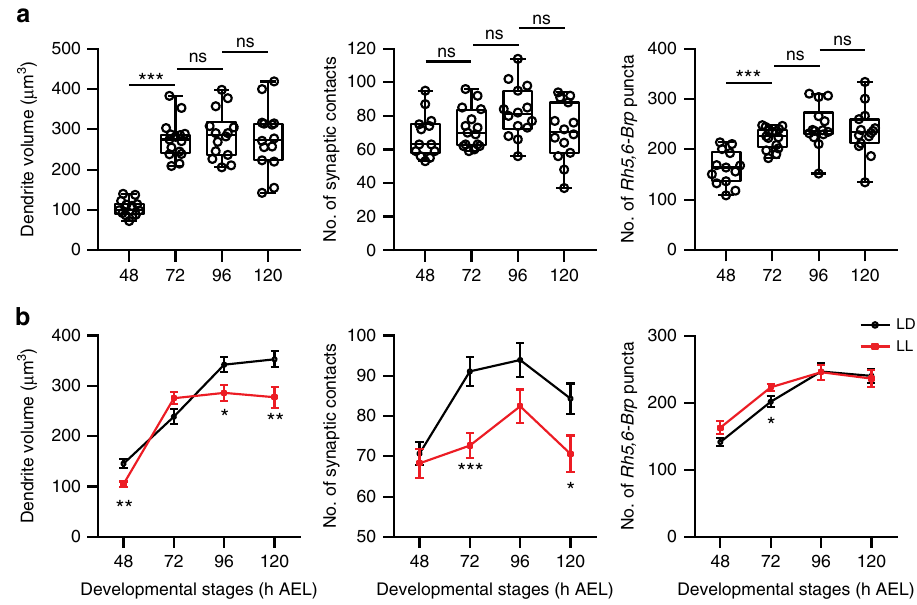
Fig. 5 Experience-dependent modi fi cations of dendrite growth and synaptogenesis in LNvs. a LL conditions alter the temporal pro fi le of dendrite growth and synapse formation. LNv dendrite volume and the number of presynaptic terminals from the BN in the LON region ( Rh5,6-Brp puncta) plateaued at 72 h, while the number of Brp puncta contacting the LNv dendrites (synaptic contacts) remains unchanged from 48 h. n = 13, 15, 14, 14 for 48, 72, 96, 120 h, respectively. Statistical signi fi cance was assessed by one-way ANOVA with Tukey ’ s post hoc test. Volume (Left), ANOVA: F 3, 52 = 32.38, P < 0.001; Tukey ’ s: P < 0.001, 48 vs 72 h; P = 0.956, 72 vs 96 h; P = 0.974, 96 vs 120 h. Synaptic contacts (Middle), ANOVA: F 3, 52 = 2.493, P = 0.07; Tukey ’ s: P = 0.859, 48 vs 72 h; P = 0.284, 72 vs 96 h; P = 0.155, 96 vs 120 h. Rh5,6-Brp puncta (Right), ANOVA: F 3, 52 = 12.96, P < 0.001; Tukey ’ s: P < 0.001, 48 vs 72 h; P = 0.369, 72 vs 96 h; P = 0.906, 96 vs 120 h. Data are presented as box plot (box, 25 – 75%; center line, median) overlaid with dot plot (individual data points). b Compared to the LD condition, LL produces a premature termination of synapse formation and dendrite volume expansion, without affecting the number of presynaptic terminals from the BN. Trend lines of the three parameters from LD or LL were plotted. Error bars represent SEMs. LD and LL compared at each developmental stage by two-tailed Student ’ s t -test. Volume (Left), 48 h: t 29 = 3.398, P = 0.002; 96 h: t 24 = 2.544, P = 0.018; 120 h: t 25 = 2.801, P = 0.01. Synaptic contacts (Middle), 72 h: t 24 = 3.825, P = 0.001; 120 h: t 25 = 2.298, P = 0.03. Rh5,6-Brp puncta (Right), 72 h: t 24 = 2.253, P = 0.034. ns, not signi fi cant; *P < 0.05, **P < 0.01, ***P < fi lopodia support synaptogenesis, the upregulation of dendrite dynamics in postsynaptic neurons is not suf fi cient to increase the synapse formation.